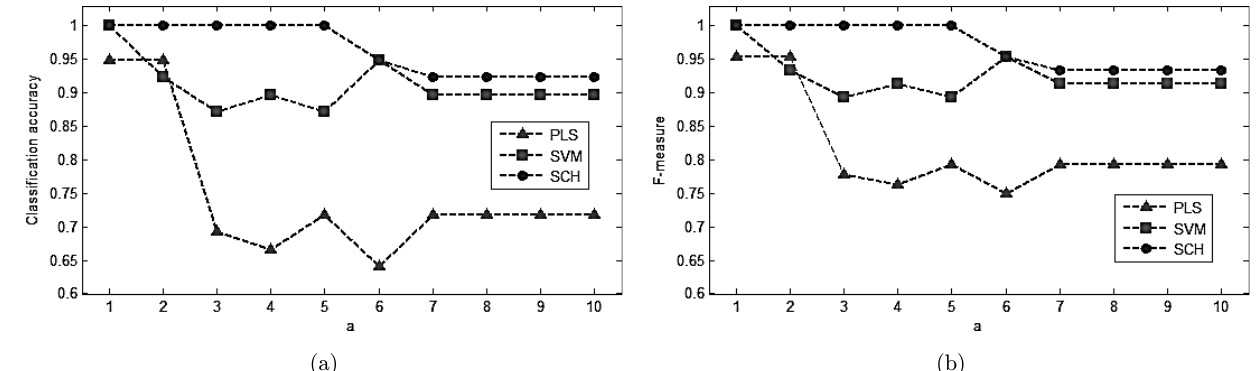
Fig. 8. The classi¯cation accuracy for the imbalanced samples.